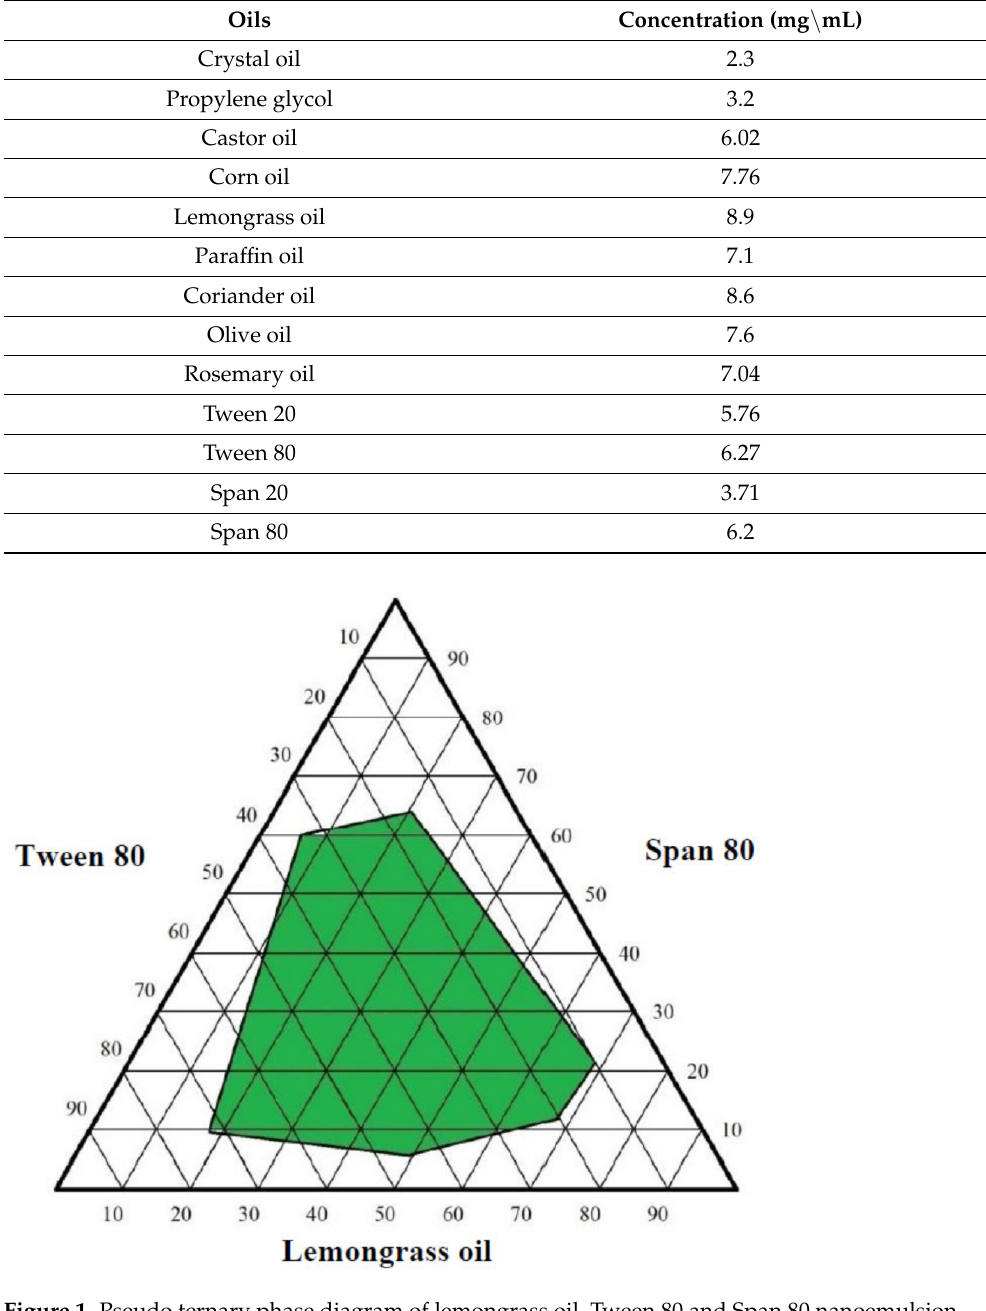
Figure 1. Pseudo ternary phase diagram of lemongrass oil, Tween 80 and Span 80